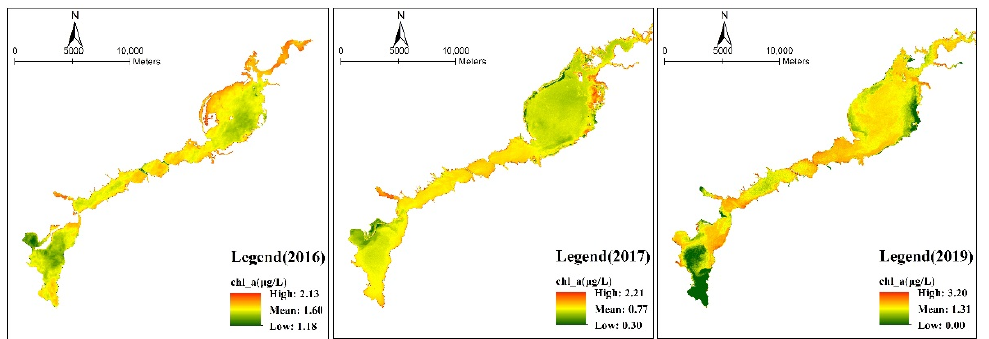
Figure 4. Distribution of chlorophyll-a concentrations in the Guanting Reservoir. The lowest and average values from 2016 to 2017 are declining. From 2017 to 2019, the highest and average values of the Guanting Reservoir are increasing. The color bar indicates the closeness of the concentration value to the mean. Red indicates values exceeding the mean, while green indicates values below the mean.